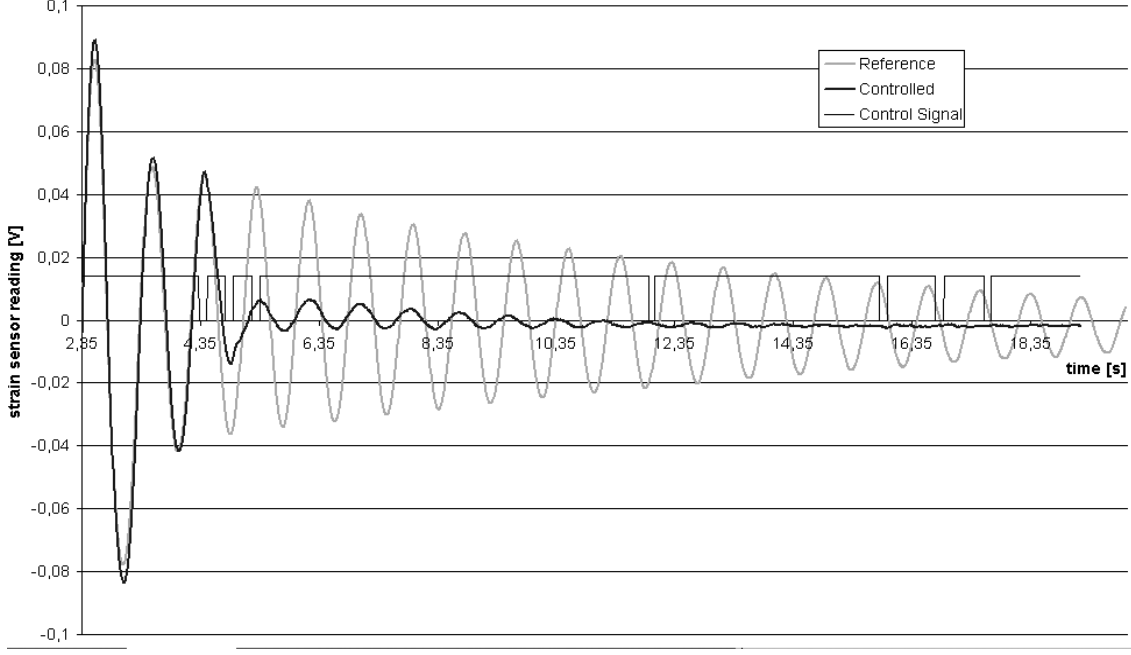
Fig. 15. Time history response of the